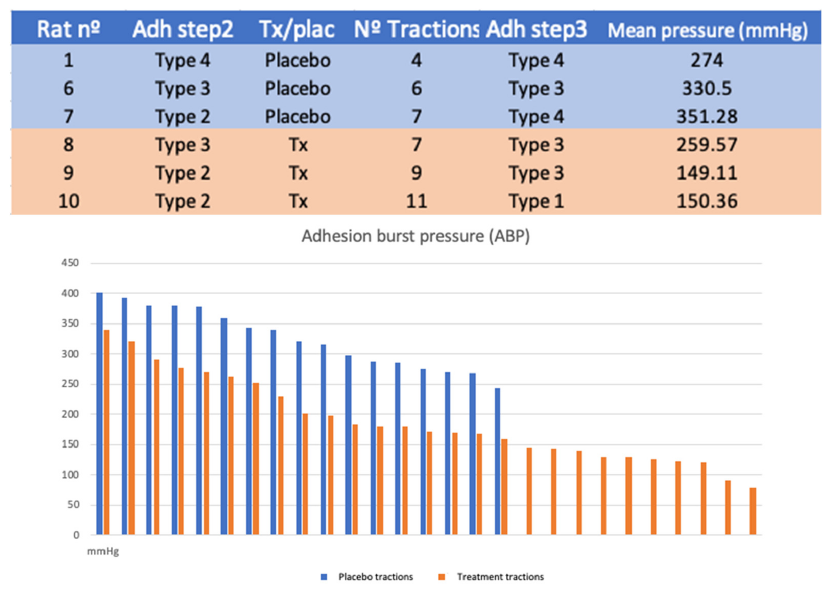
Figure 6. Table experiment B. Graph of experiment B: pressure distribution according to the tractions performed ( p < 0.001).